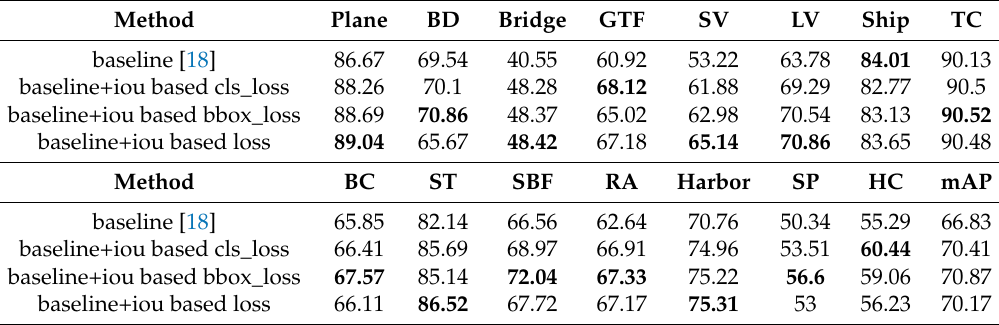
Table 6. The impact of the IoU-based Weighted Loss.we evaluate on val set.